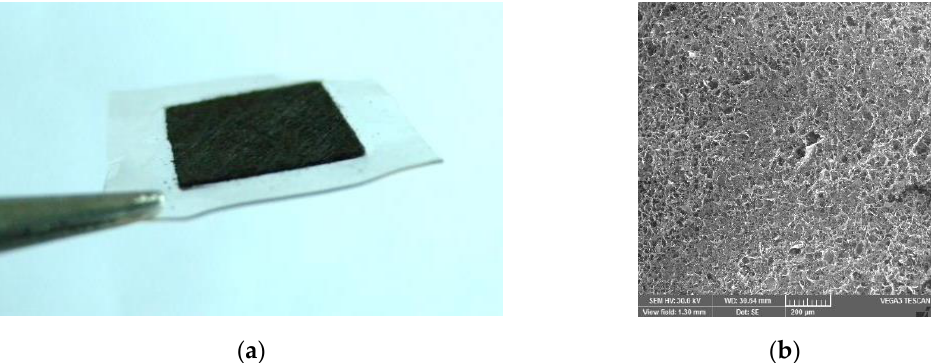
Figure 4. Picture of the passive micro-direct methanol fuel cell (μ-DMFC) with the trilaminar-catalytic layer structure: ( a ) Photograph of the membrane electrode assembly (MEA) with the trilaminar-catalytic layer; ( b ) partial pore former (PF) cathode scanning electron microscope image (SEM).